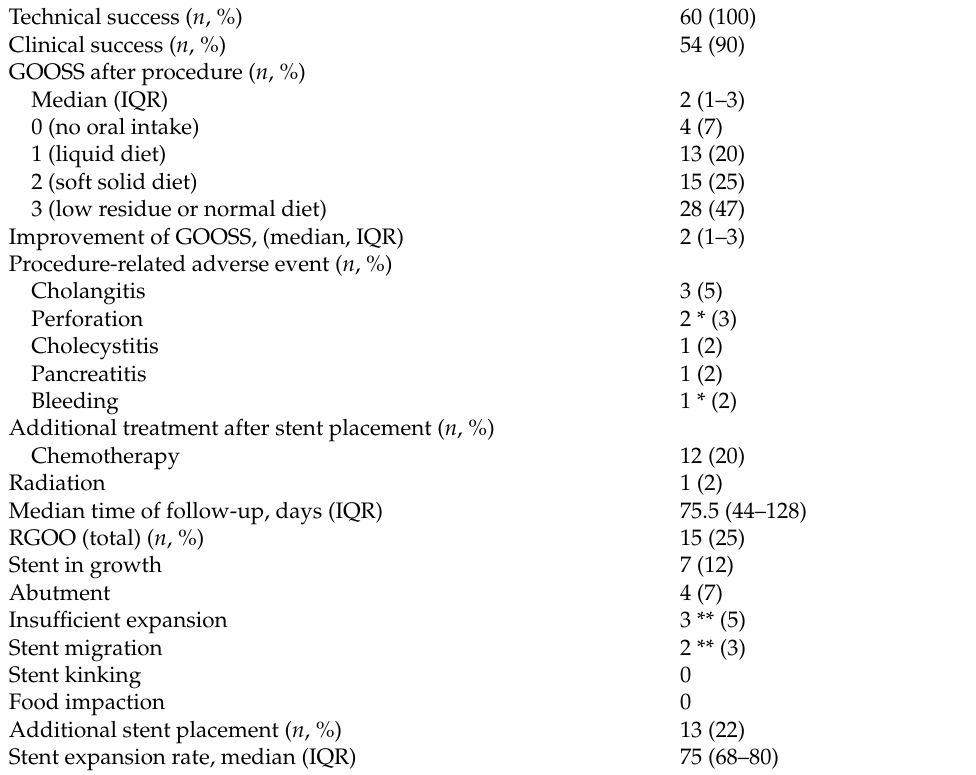
Table 3. Clinical outcomes in patients after stent